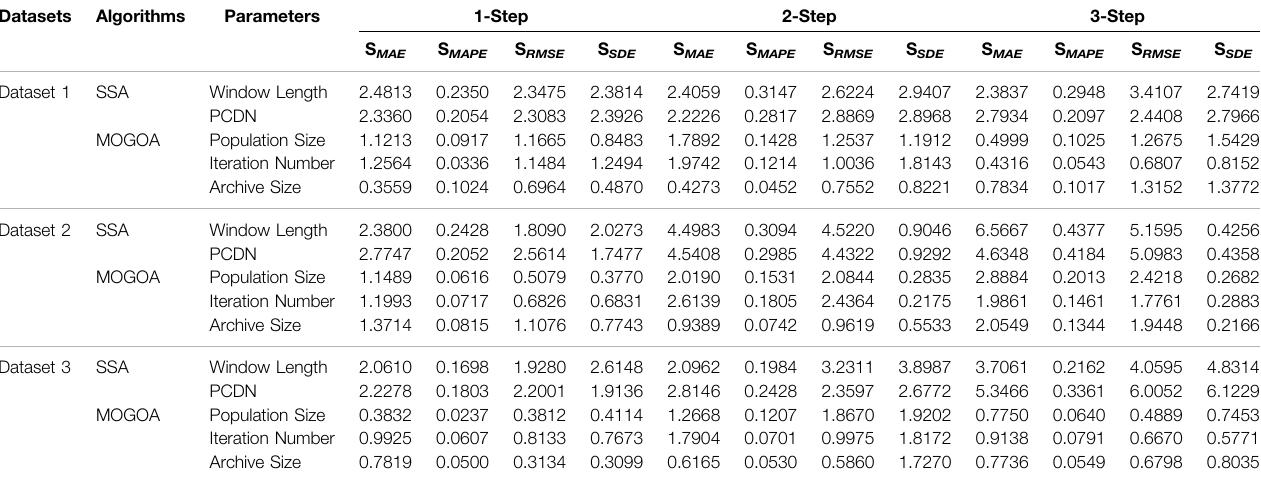
TABLE 9 | STD values of the results acquired by changing parameters.